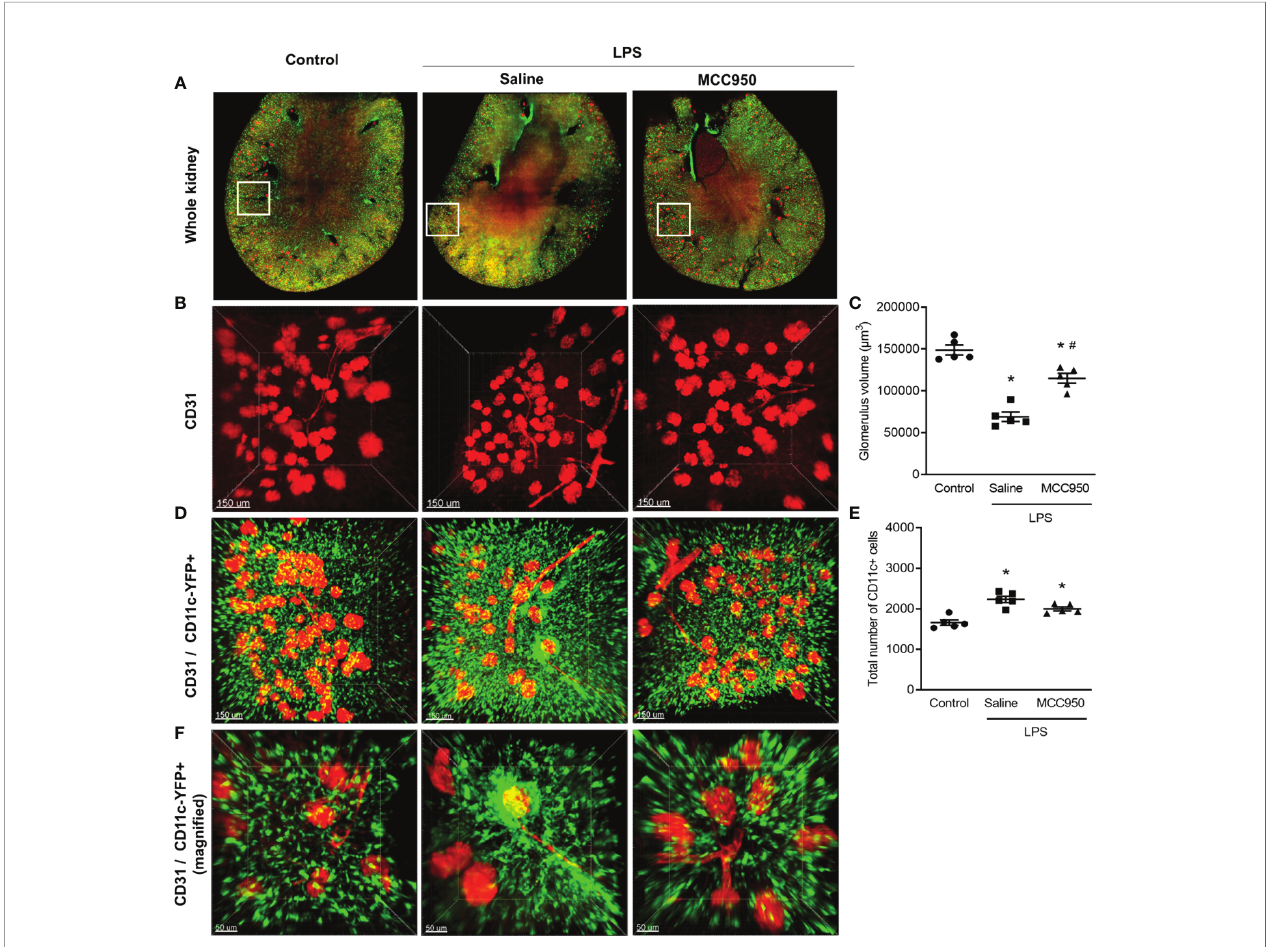
FIGURE 2 | Alteration of the spatial distribution of renal mononuclear phagocytes and vasculature after LPS treatment. (A) LSFM image of the whole kidney. (B) CD31 staining. (C) Glomerulus volume measured from CD31 staining. (D) Merged image of CD11c-YFP and CD31 (scale bars, 150 m m). (E) Total number of CD11c-YFP+ cells. The total cell number was counted per fi eld of view. (F) Merged image of CD11c-YFP and CD31 (magni fi ed view of periglomerular and perivascular lesions, scale bars, 50 m m). Data are represented as the mean ± SEM (n=5 per group). * P <0.05 versus the normal control, # P <0.05 versus the saline- treated LPS